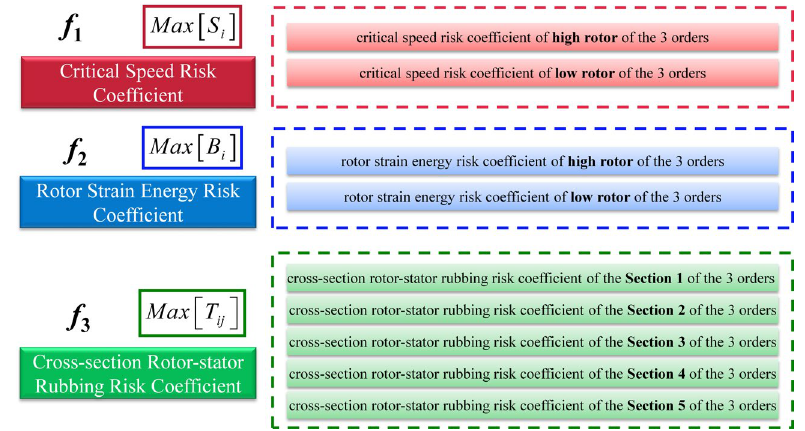
Figure 12. Optimization targets.